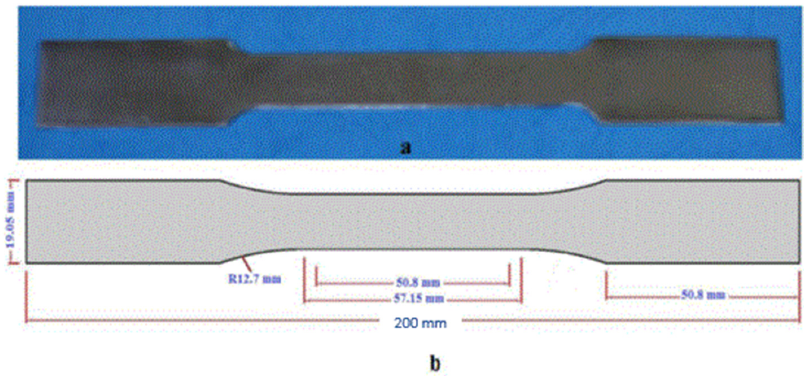
Fig. 3. ASTM: E8/8M Standard dimensions for tensile test specimens: (a) real& (b) schematic of the tensile test specimens.